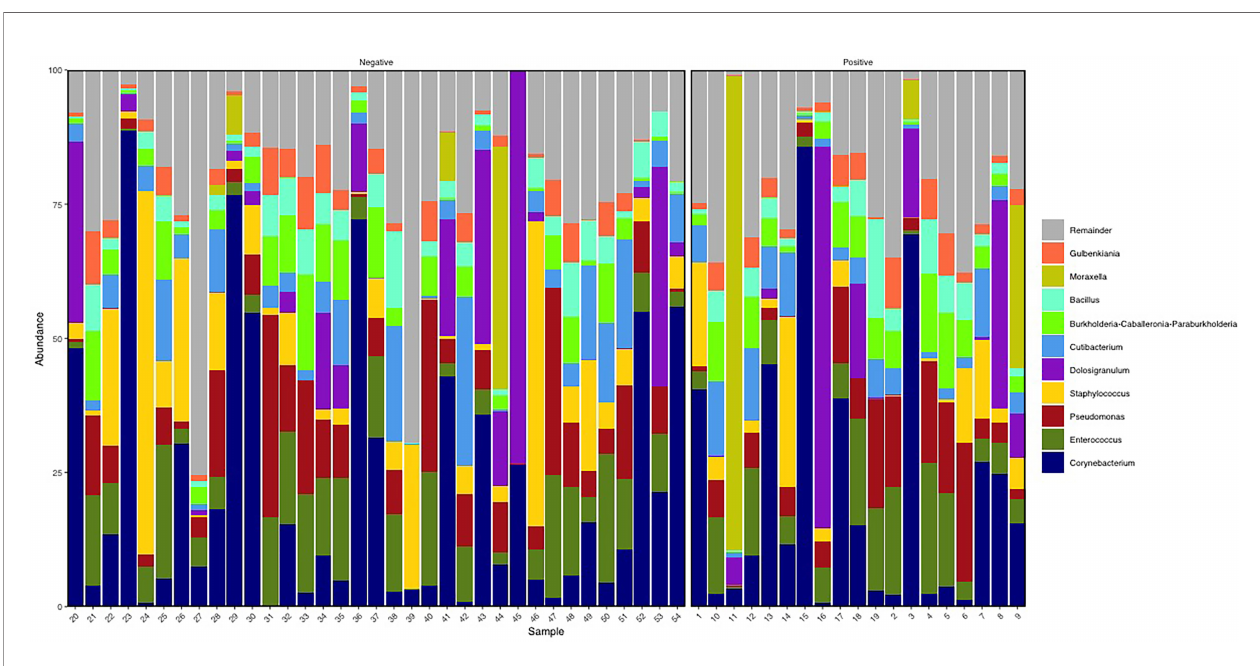
FIGURE 1 | Descriptive nasopharyngeal bacterial microbiota (BNM) genus-pro fi le composition in the two groups SARS-CoV-2 RNA negative (i.e., negative, N = 35) and SARS-CoV-2 RNA positive (i.e., positive, N = 19). Here the top 10 most abundant genera are represented. Figure generated by R software (version 4.1.2 https://www.r-project.org/)